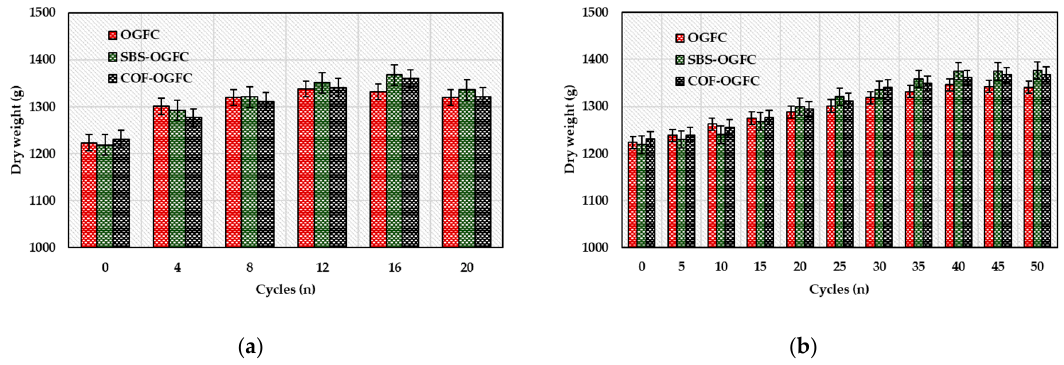
Figure 10. Dry weight of three permeable asphalt mixtures with different cycles. ( a ) Spring clogging procedure; ( b ) Summer clogging procedure.